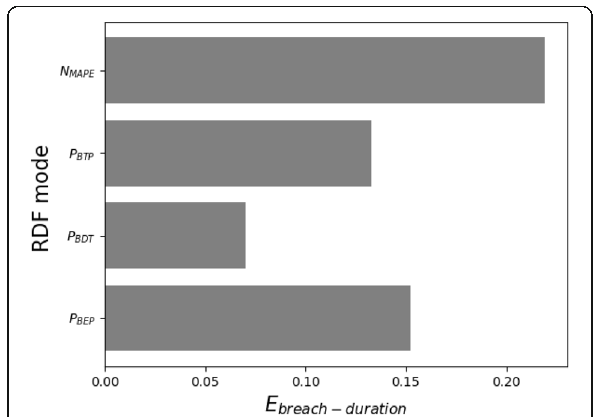
Fig. 13 Ebreach-duration of N-mode and P-mode models